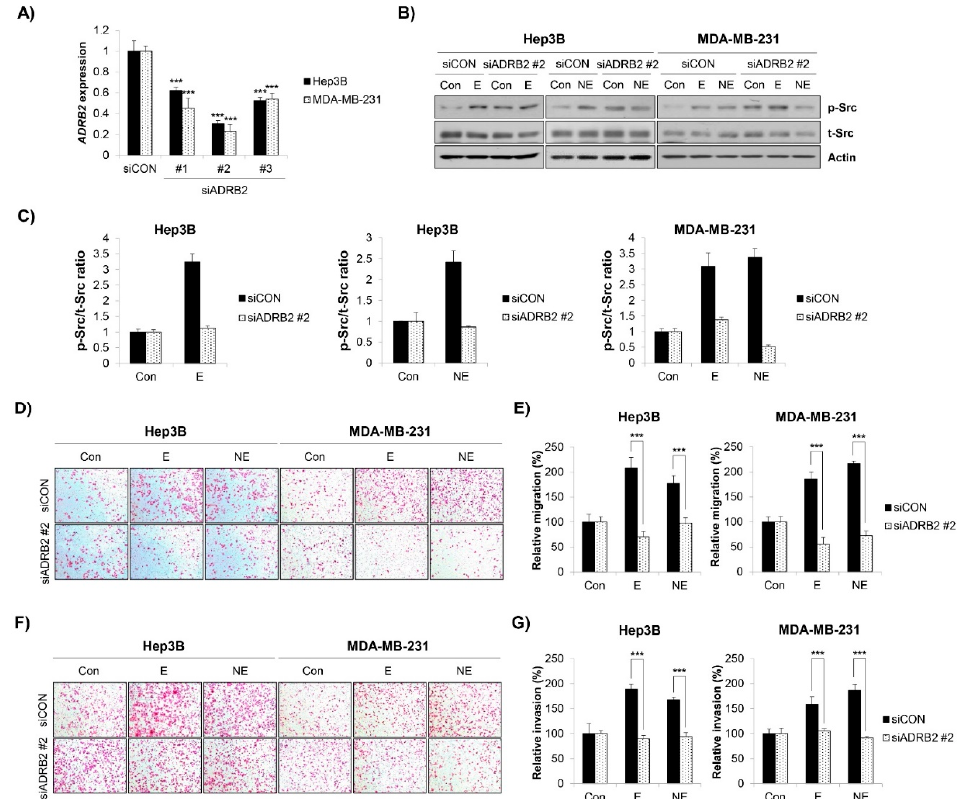
Figure 4. β 2-AR is involved in E/NE-induced Src activation and the metastatic ability of Hep3B and Figure 4. β 2 ‐ AR is involved in E/NE ‐ induced Src activation and the metastatic ability of Hep3B and MDA ‐ MB ‐ 231 cells. ( A – G ) Hep3B human HCC cells and MDA ‐ MB ‐ 231 human BC cells were trans ‐ MDA-MB-231 cells. ( A – G ) Hep3B human HCC cells and MDA-MB-231 human BC cells were